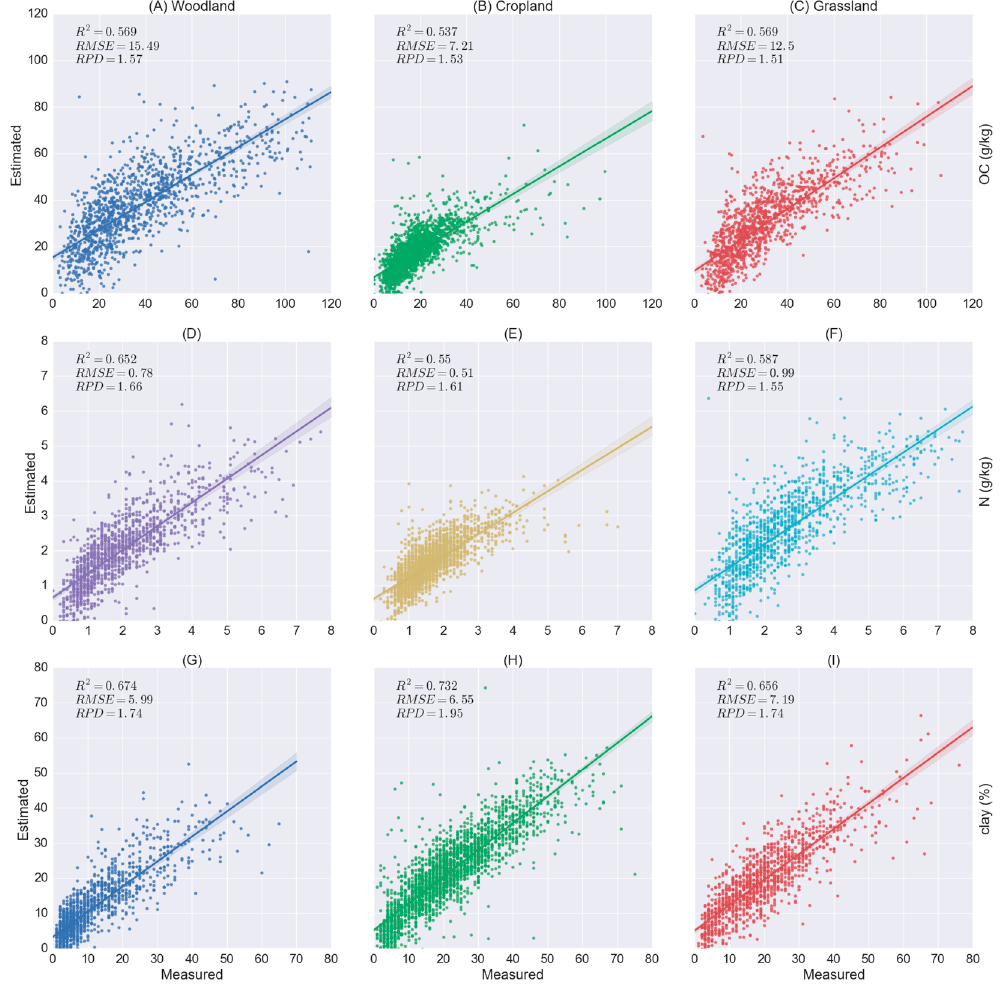
Figure 4. Results of soil property estimation accuracies using the partial least squares (PLS) regression method. ( A – C ) are organic carbon accuracies for samples from woodland, cropland, and grassland soils, and ( D – F ) are N accuracies, and ( G – I ) are clay accuracies. Table 2. Optimised parameters for the spectroscopic model using the PLS-gradient-booted decision tree (GBDT) method.